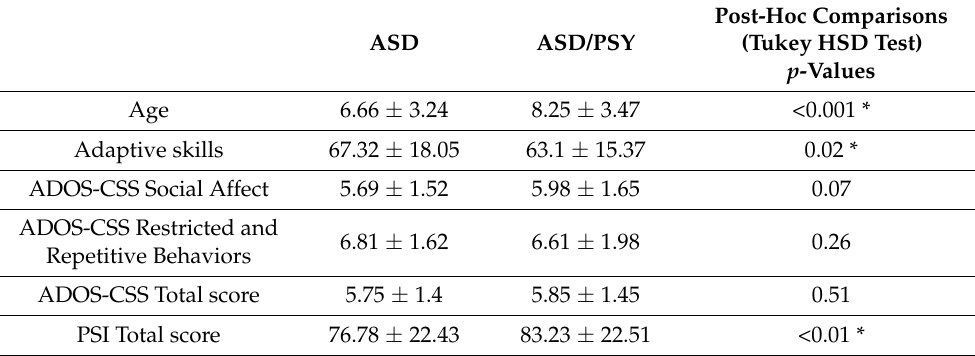
Table 2. Means and standard deviations for age, adaptive abilities, and ADOS-2 CSS scores. *: p <